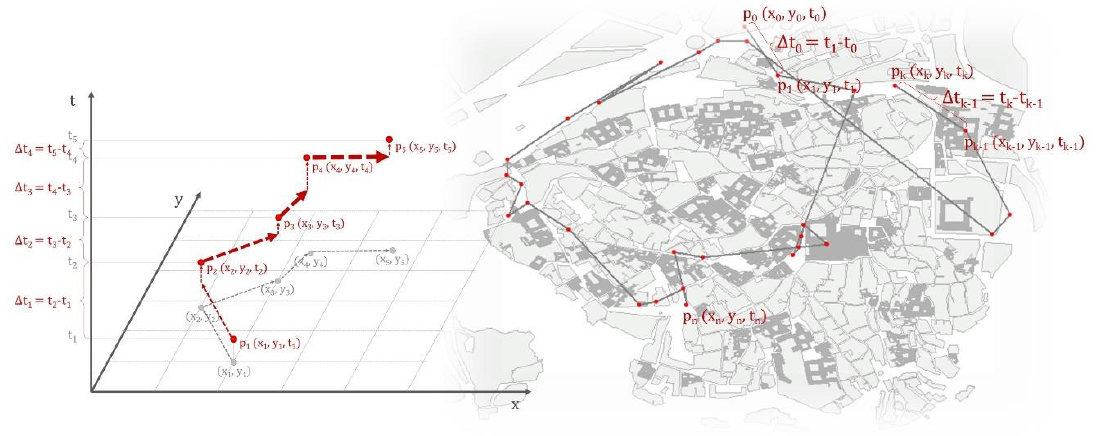
Figure 4. Conceptual scheme of how to build routes from Flickr photos. Source: Authors’ own